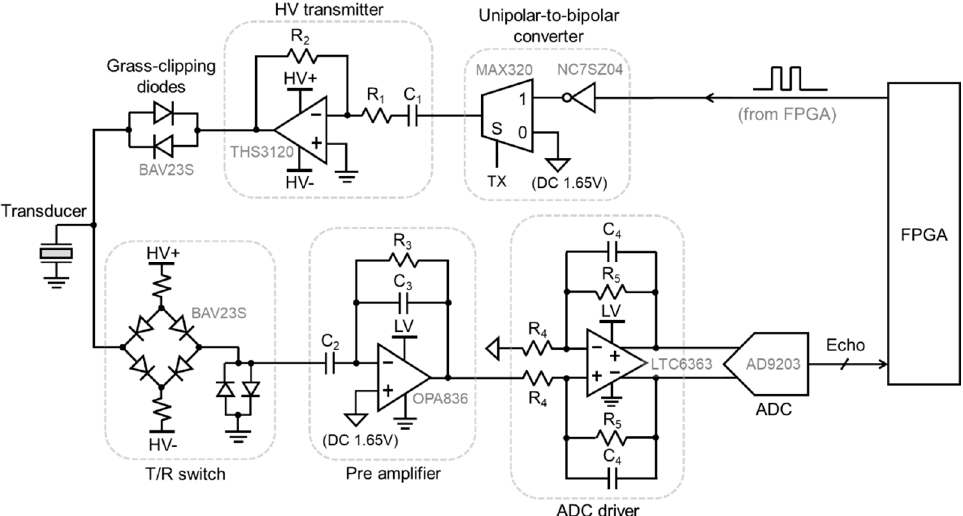
Figure 3. Circuit diagram of analog interface; HV: high voltage; T/R: transmit/receive; DC: direct current; ADC: analog-to-digital converter. current; ADC: analog-to-digital